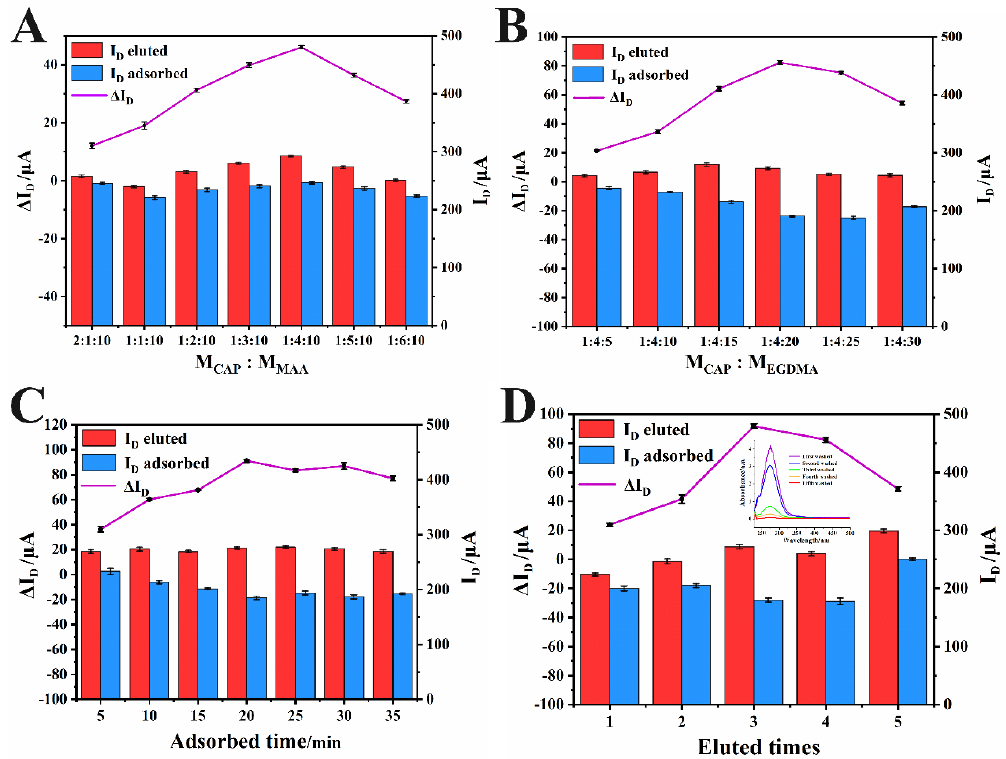
Figure 3. Discovering the best experimental parameters: ( A ) M CAP /M MAA ratio; ( B ) M CAP /M EGDMA ratio; ( C ) adsorption time; ( D ) elution times (illustration: the UV absorption spectrum of CAP in eluate after elution times of t = 1, 2, 3, 4 and 5; n = 3).